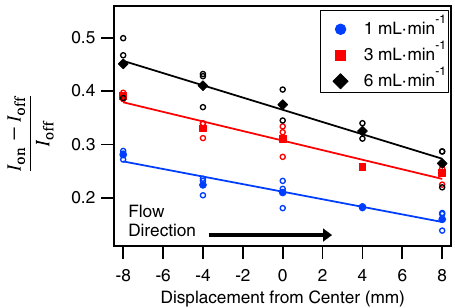
Fig. 3 Gradient in the increase of the v-SFG intensity for different fl ow rates. At different positions, the relative increase in the v-SFG intensity at the CaF 2 -water interface is calculated based on averaged steady-state spectra under fl ow-on and fl ow-off conditions as marked in Fig. 1c and Supplementary Fig. 1, for the three indicated fl ow rates. The open circles represent the relative increase upon fl ow and the fi lled symbols the mean at their corresponding positions. The error of the individual ratios (open circles) due to small fl uctuations within the steady-states of one fl ow-on/off cycle (see Fig. 1c of the main text and Supplementary Fig. 1) is negligible compared to the spread. The solid lines are guides to the eye. The solution used was a 1 mM NaCl solution in pH 3 HCl with an additional 1 µ M NaF. The addition of a very low NaF concentration constrains the number of unknown parameters in our model. Comparing the black data points here with the data points in Supplementary Figure 2 see shows that the added 1 µ M NaF does not noticeably in fl uence the interfacial events. The position is given as displacement from the center, with values increasing in the direction of fl ow, indicated by the